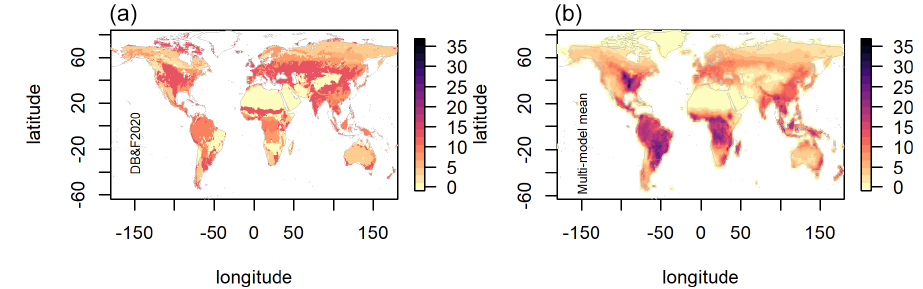
Figure 2. Map of observation-biome-based estimates of BNF in kgNha − 1 yr − 1 (a) and a map of multi-model mean BNF for the period 1980–2015 (b)